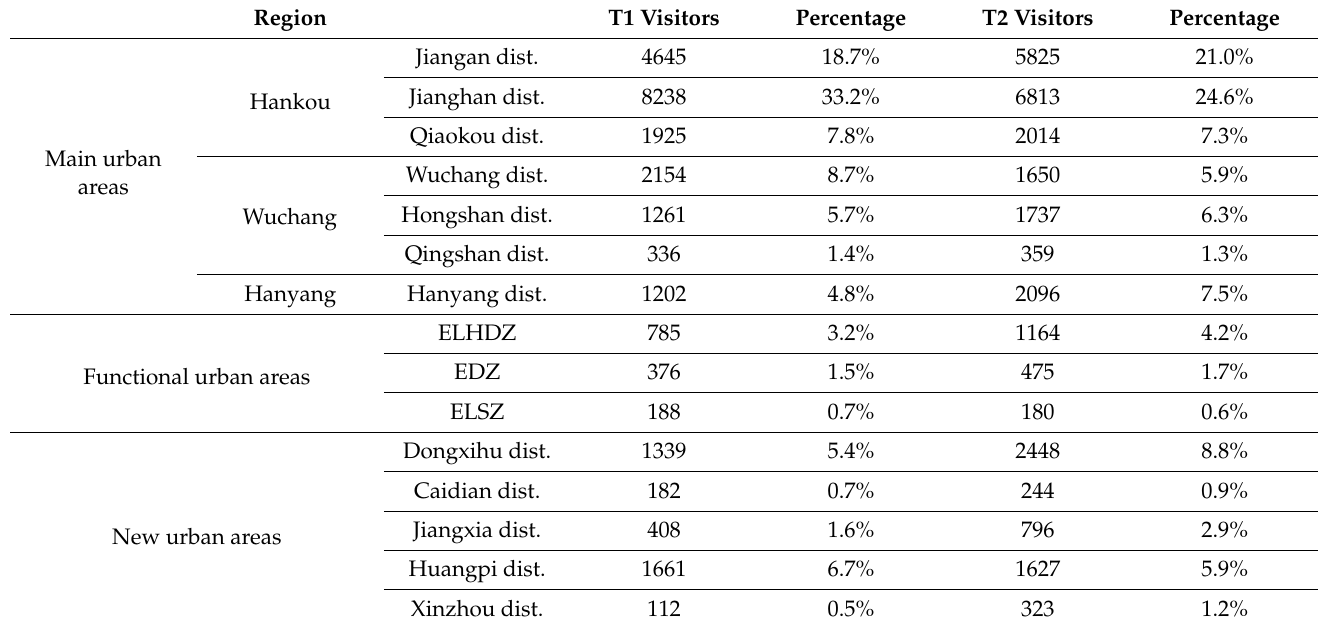
Table 2. Origins and destinations of visitors to the market for non-working purposes.